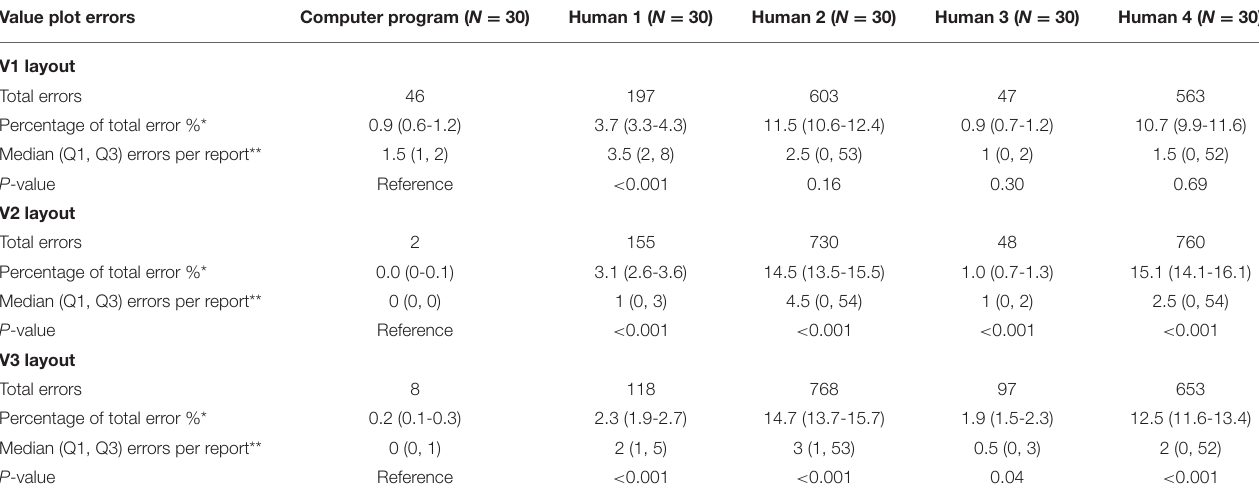
TABLE 4 | Comparison between computer program and human on value plot extraction